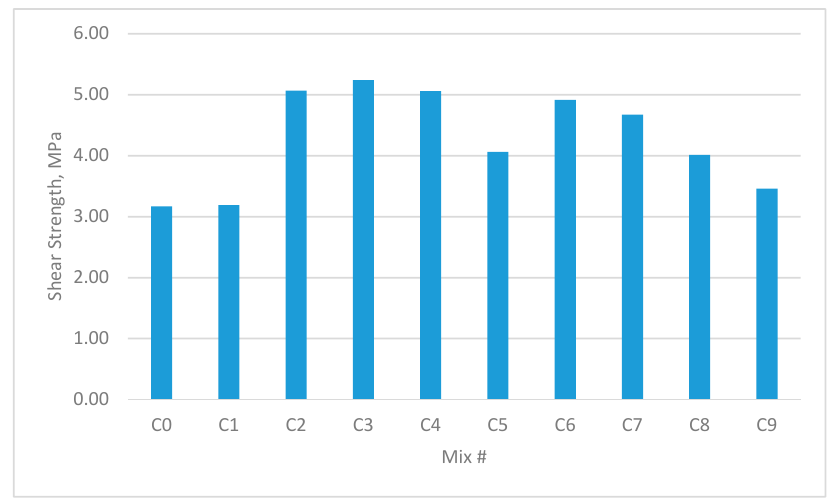
Figure 6. Shear strength of concrete beams with W/B ratio 0.3.